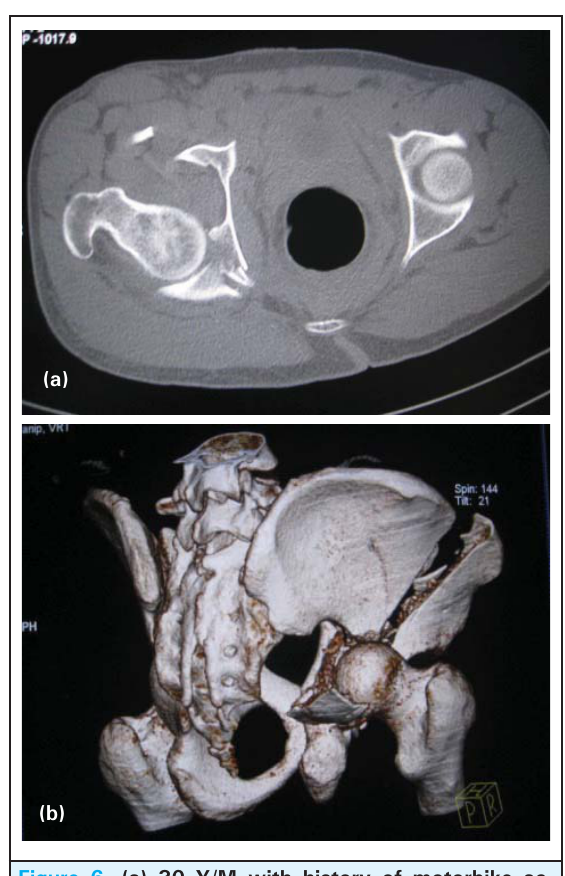
Figure 6. (a) 30 Y/M with history of motorbike ac- cident. Axial and 3-D images of the pelvis shows dis- placed fracture of posterior wall of right acetabulum with posterior dislocation. (b) 3-D images demon- strates long segment iliac bone fracture and posterior dislocation of the hip joint.